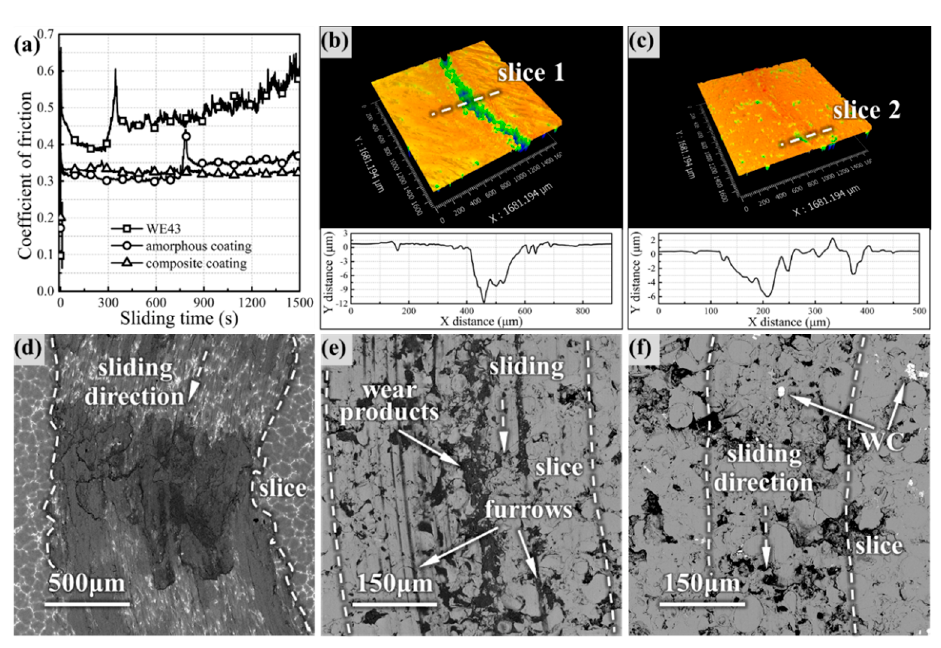
Figure 5. Wear test of WE43 and coatings: ( a ) COF of WE43 and Fe-based amorphous coatings; ( b ) and ( c ) 3D worn surface topography of the amorphous coating and composite coating,